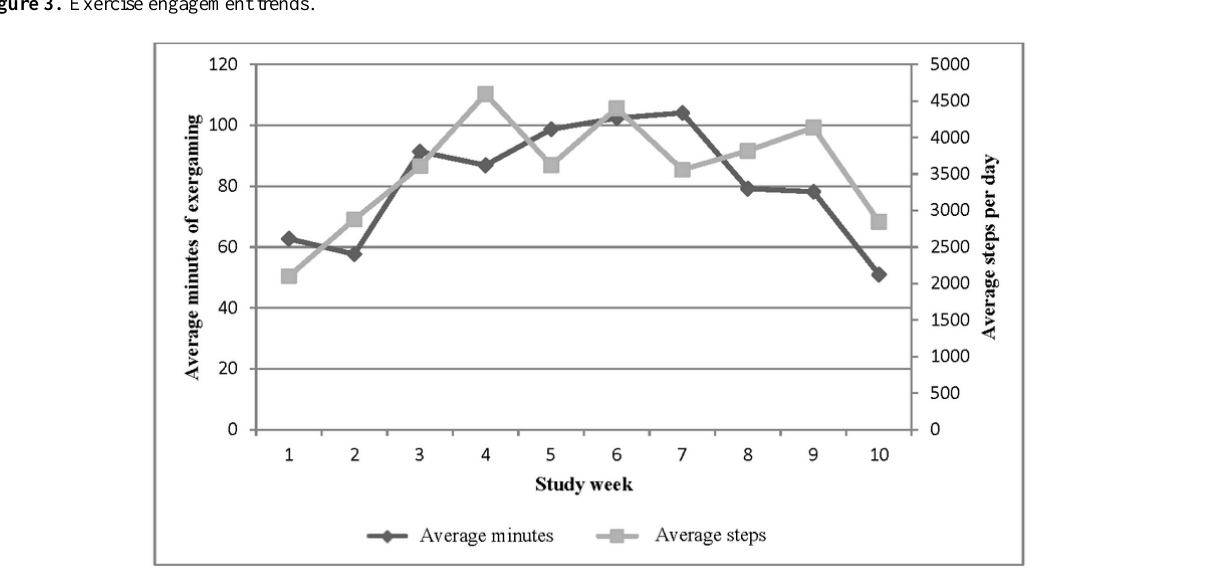
Figure 3. Exercise engagement